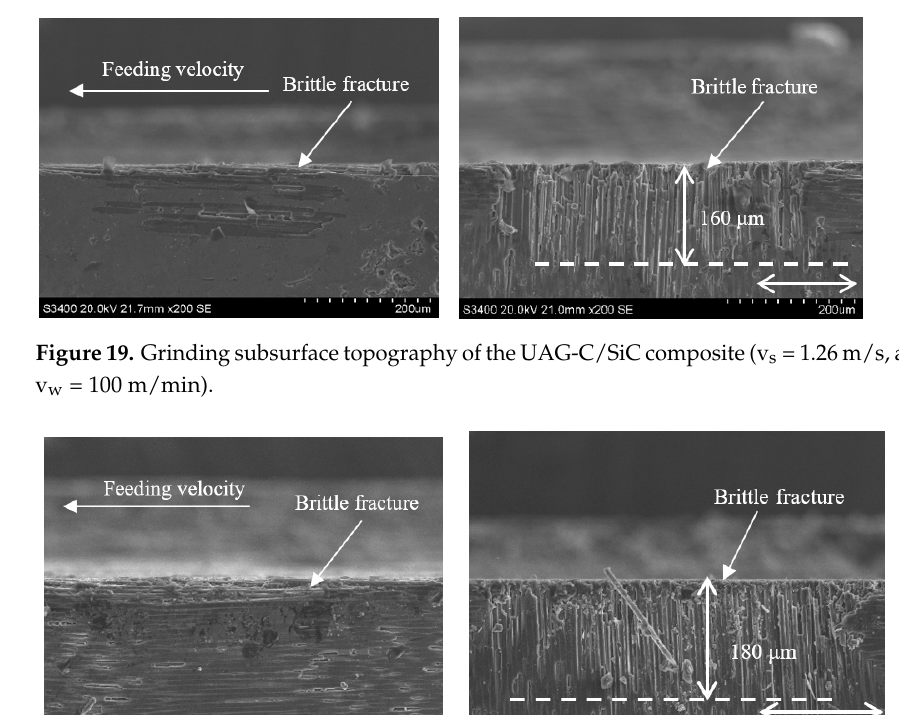
Figure 18. Grinding subsurface topography of the CG-C/SiC composite (v s = 1.26 m/s, a p = 0.4 mm, v w = 100 m/min).